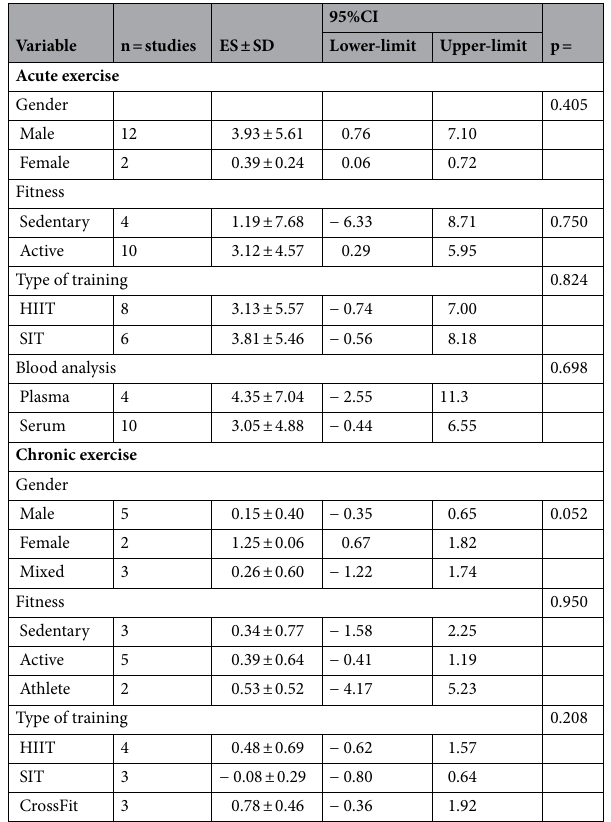
Table 2. Moderator variables for the effect of acute and chronic exercise on